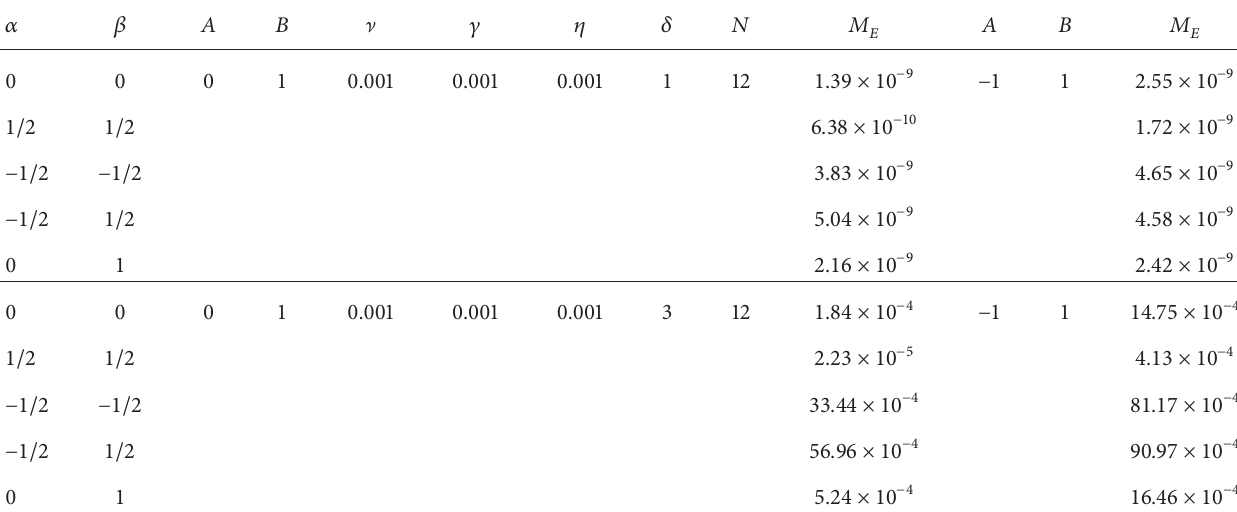
Table 4: Maximum absolute errors with various choices of (𝛼,𝛽) for both values of 𝛿 = 1, 3 Example